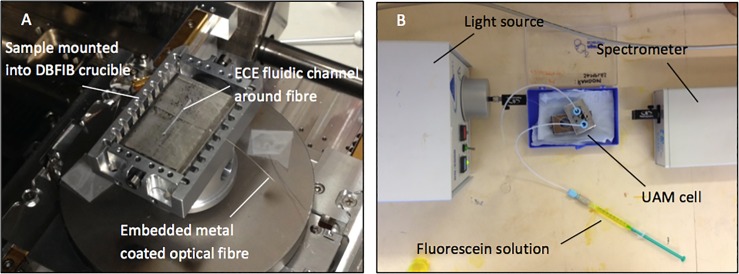
(A) UAM cell featuring embedded fibre mounted for DBFIB work (B) configuration used in analysis of nicotinamide and fluorescein solutions.